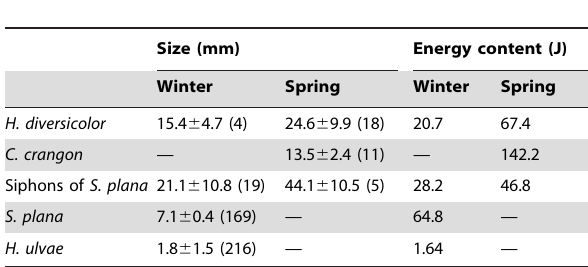
Table 2. Mean sizes ( 6 SD, sample sizes in parenthesis) and mean individual energy content of prey consumed by dunlins in winter and spring.